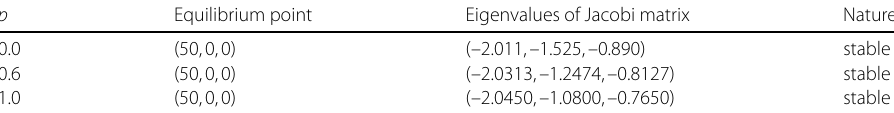
Table 4 The nature of the axial equilibrium point for different values of the parameter p p Equilibrium point Eigenvalues of Jacobi matrix Nature 0.0